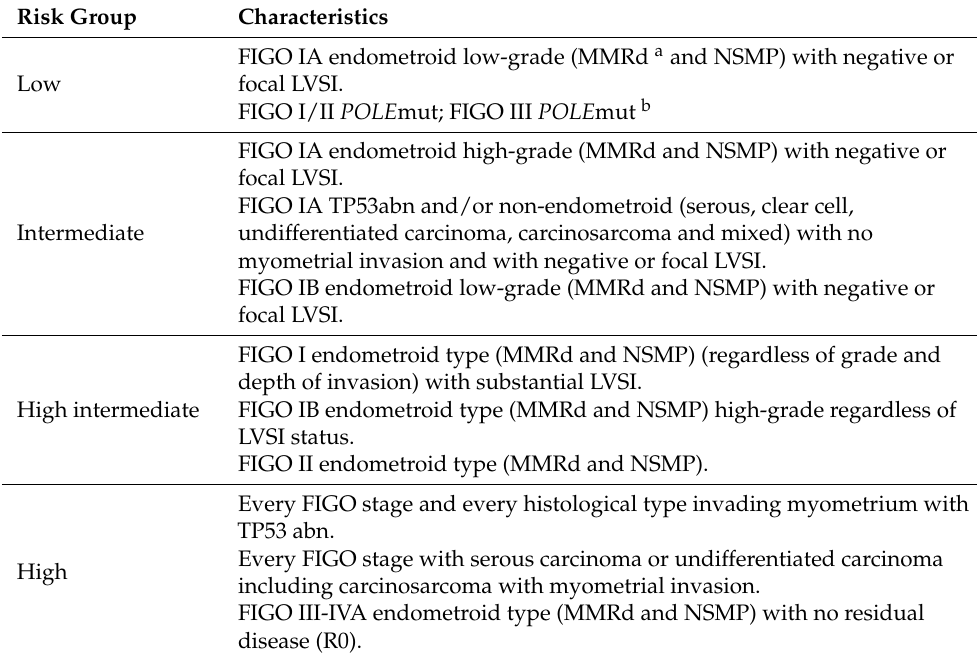
FIGO III-IVA endometroid type (MMRd and NSMP) with no residual disease